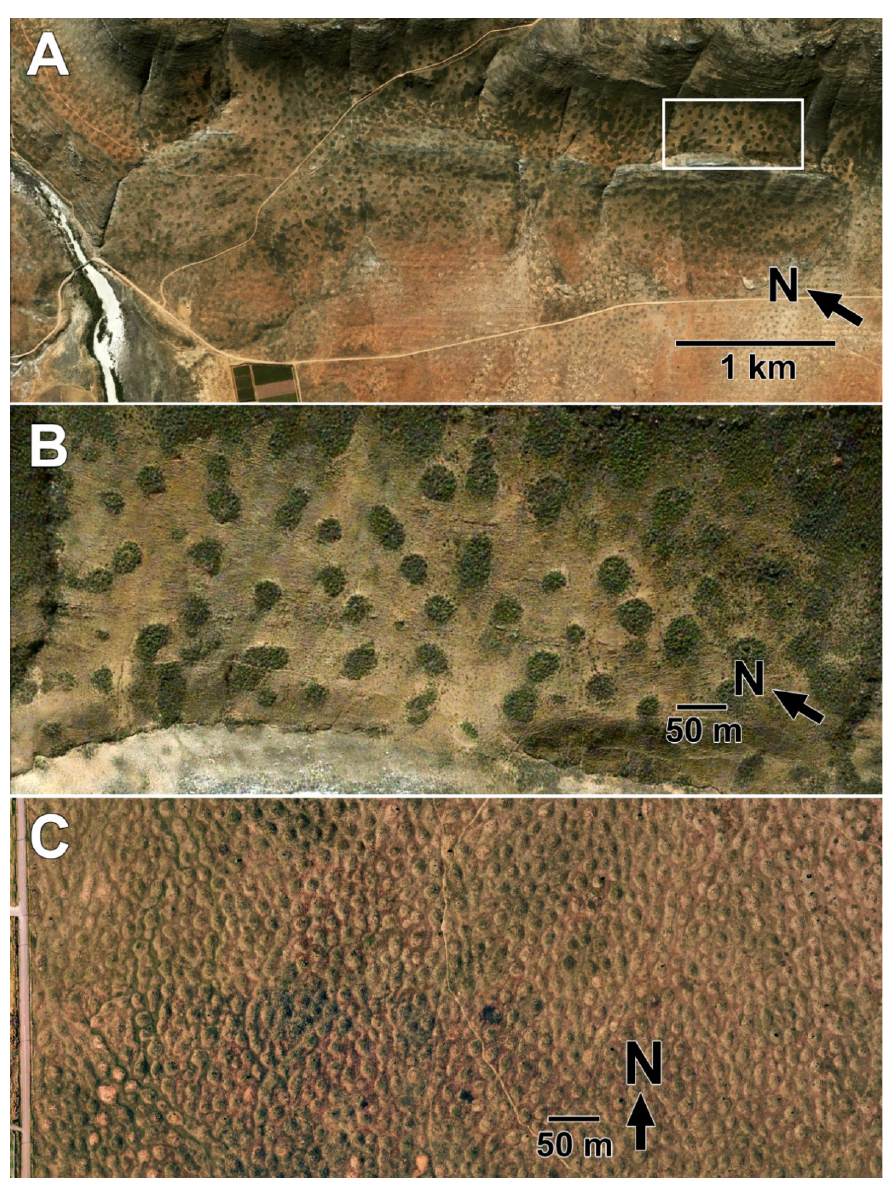
Figure 2. ( A ). Google Earth™ view of an area 14 km south-southeast of Klawer, Western Cape. The wide bright white linear feature on the left is the Doring River. The bridge crossing on the river is located at −31.86948° S, 18.68291° E. The lower half of the view consists of agricultural lands that have been moderately to highly disturbed by livestock pasture modifications and cultivation. The upper half consists of gentle to moderately steep hillslopes that have been little impacted. The white rectangle in the upper right is the area enlarged in ( B ) (below). ( B ) A close-up of the area enclosed in the white rectangle in the upper right-hand corner of ( A ). Coordinates of the centre of the view are −31.89739° S, 18.71243° E. The view consists of slopes ranging from less than 10% inclination (lowermost areas) to moderately steep (40% inclination) in upper half. Heuweltjies on the slopes are densely covered with vegetation compared to surrounding areas, whereas those of the valley floor are highly disturbed with minimal plant cover (J. McAuliffe, personal observations, October 2016).